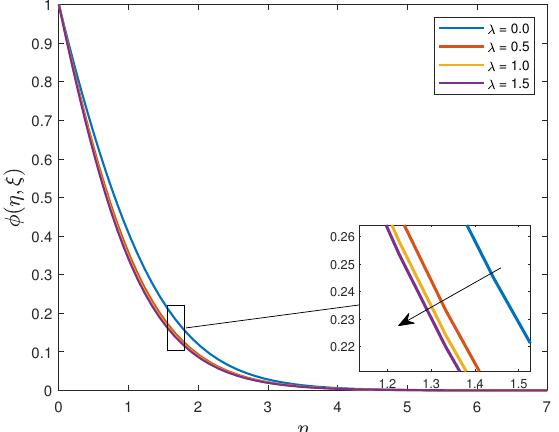
Figure 6. The influence of λ on fluid